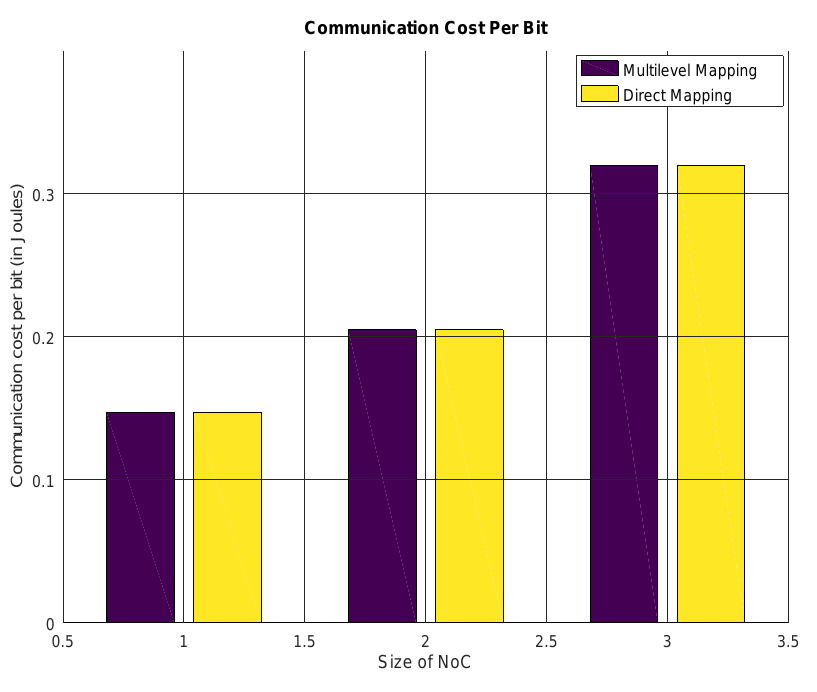
Figure 15. Communication cost per